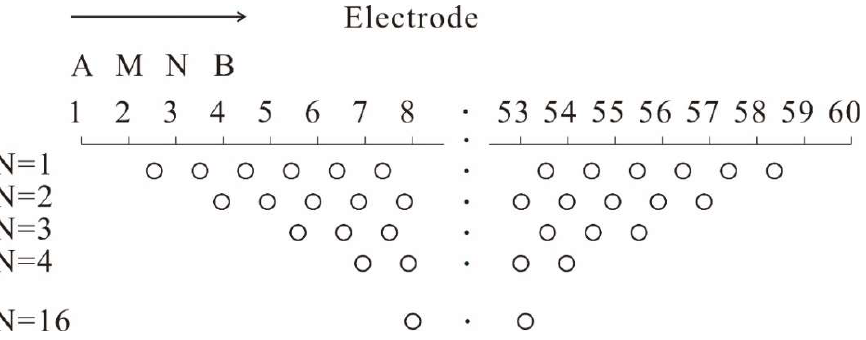
Figure 1. Schematic diagram of measuring system.